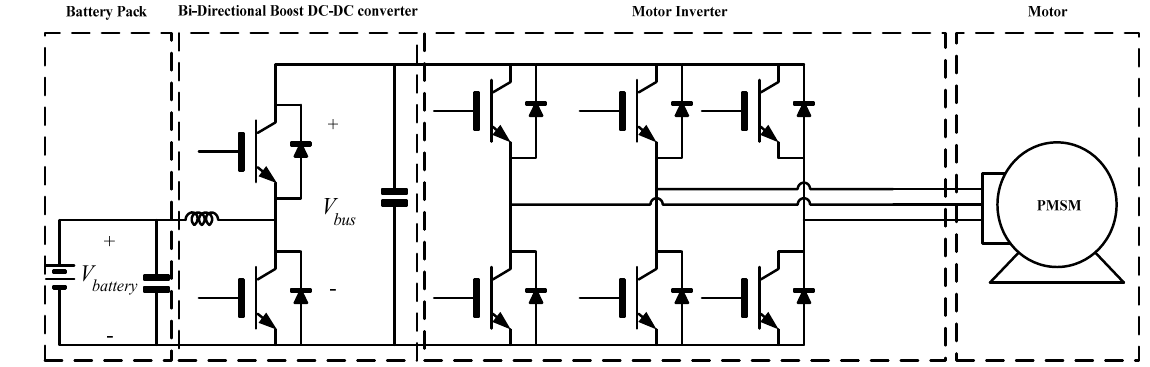
Figure 1. Typical Powertrain architecture highlighting conventional bidirectional boost converter.